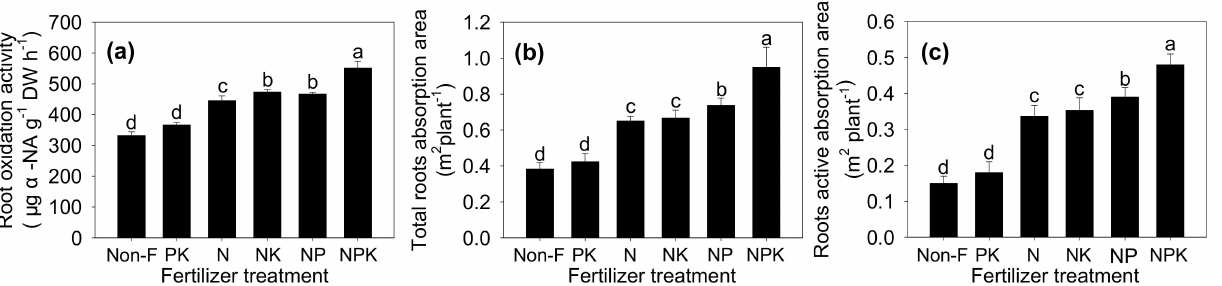
Figure 6. Destructively measured root oxidation activity ( a ), total roots absorption area ( b ), and roots active absorption area ( c ) for rice at 42 d after transplanting. Vertical bars indicate ± SE ( n = 3). The lowercase letters indicate a significant difference among the treatments ( p <